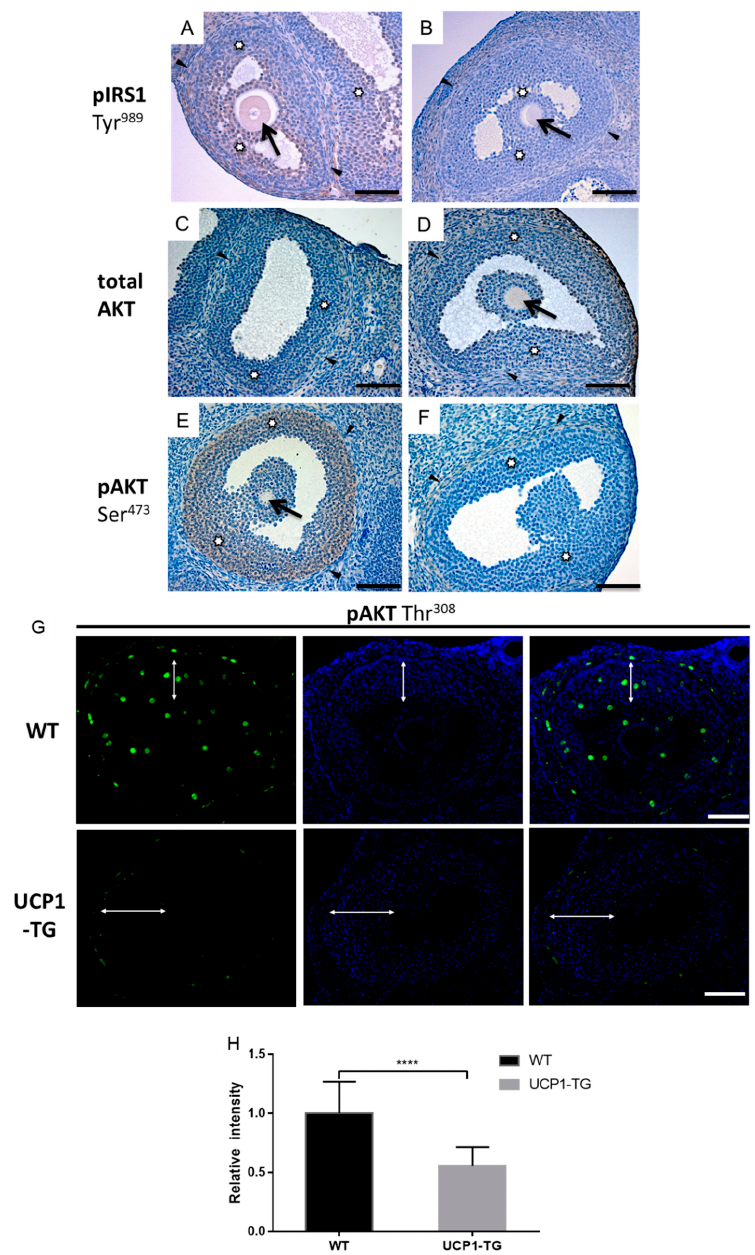
Figure 7. Immunostaining for phosphorylated IRS1, total and phosphorylated AKT Ser473 (brown staining) as markers of IGF1 signaling in healthy antral follicles of WT ( A , C , E ) and UCP1-TG ( B , D , F ) mice; immunofluorescence staining for phosphorylated AKT Thr 308 in WT and UCP1-TG ( G , H ). Representative immunostaining of IRS1 phosphorylated at Tyr989 ( A , B ), total AKT ( C , D ), AKT phosphorylated at Ser473 ( E , F ) and AKT phosphorylated at Thr308, green, Thr308; blue, DAPI ( G ). Phosphorylation of IRS1 and AKT Ser473 is present in the granulosa cells of healthy antral follicles in WT ovaries but faint to absent in UCP1-TG mice. Similarly, immunofluorescence analysis showed the significantly decreased intensity of phosphorylated AKT Thr 308 in the granulosa cells of healthy antral follicles in UCP1-TG mice in comparison to WT ( H ). ( H ): Student’s t-test, ****, p < 0.0001; total AKT immunostaining is moderate in the granulosa cells of WT animals and UCP1-TG mice. There was no difference in theca and stromal cell staining between the WT and UCP1-TG. Inserts show a detail of the granulosa layer. Arrow—oocyte, asterisk ( A – F ) and white two-sided arrow ( G )—granulosa cells, arrowheads—theca cells. Scar bar represent 50 µ